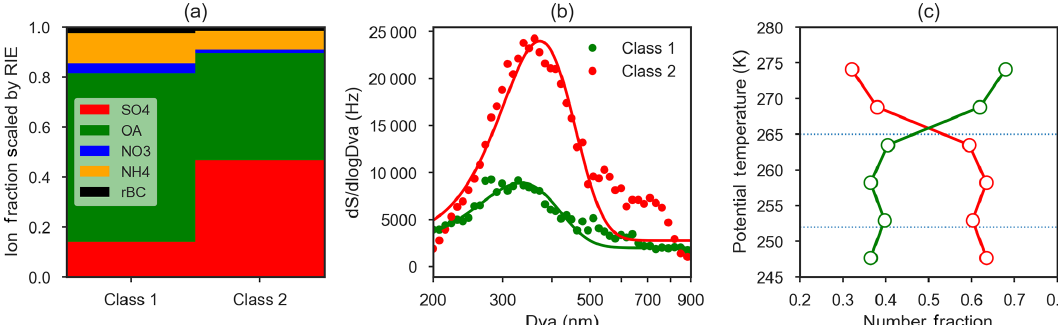
Figure 10. Summary of k -means cluster analysis of 1677 single-particle (ETSP) spectra obtained on two flights (8 and 13 April 2015). (a) Bar chart of relative ion fraction scaled by the relative ionization efficiency (RIE) of each species, for two particle classes obtained by k - means cluster analysis. Particle class 1 is referred to as “organic-rich” and class 2 is referred to as “sulfate-rich”. (b) Mean size distributions (expressed as dSignal / dlogDva, Hz) of the two particle classes (points) and Gaussian fits to the observations (lines). (c) Mean relative abundance of class 1 (green, organic-rich) and class 2 (red, sulfate-rich) binned by potential temperature. Horizontal lines represent the divisions between the lower, middle and upper polar